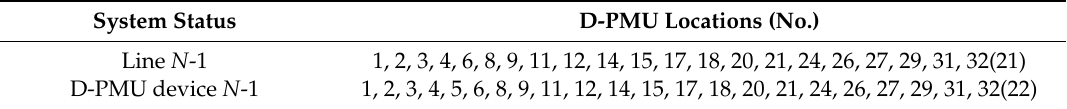
Table 4. Optimal D-PMU placement under N -1 fault condition